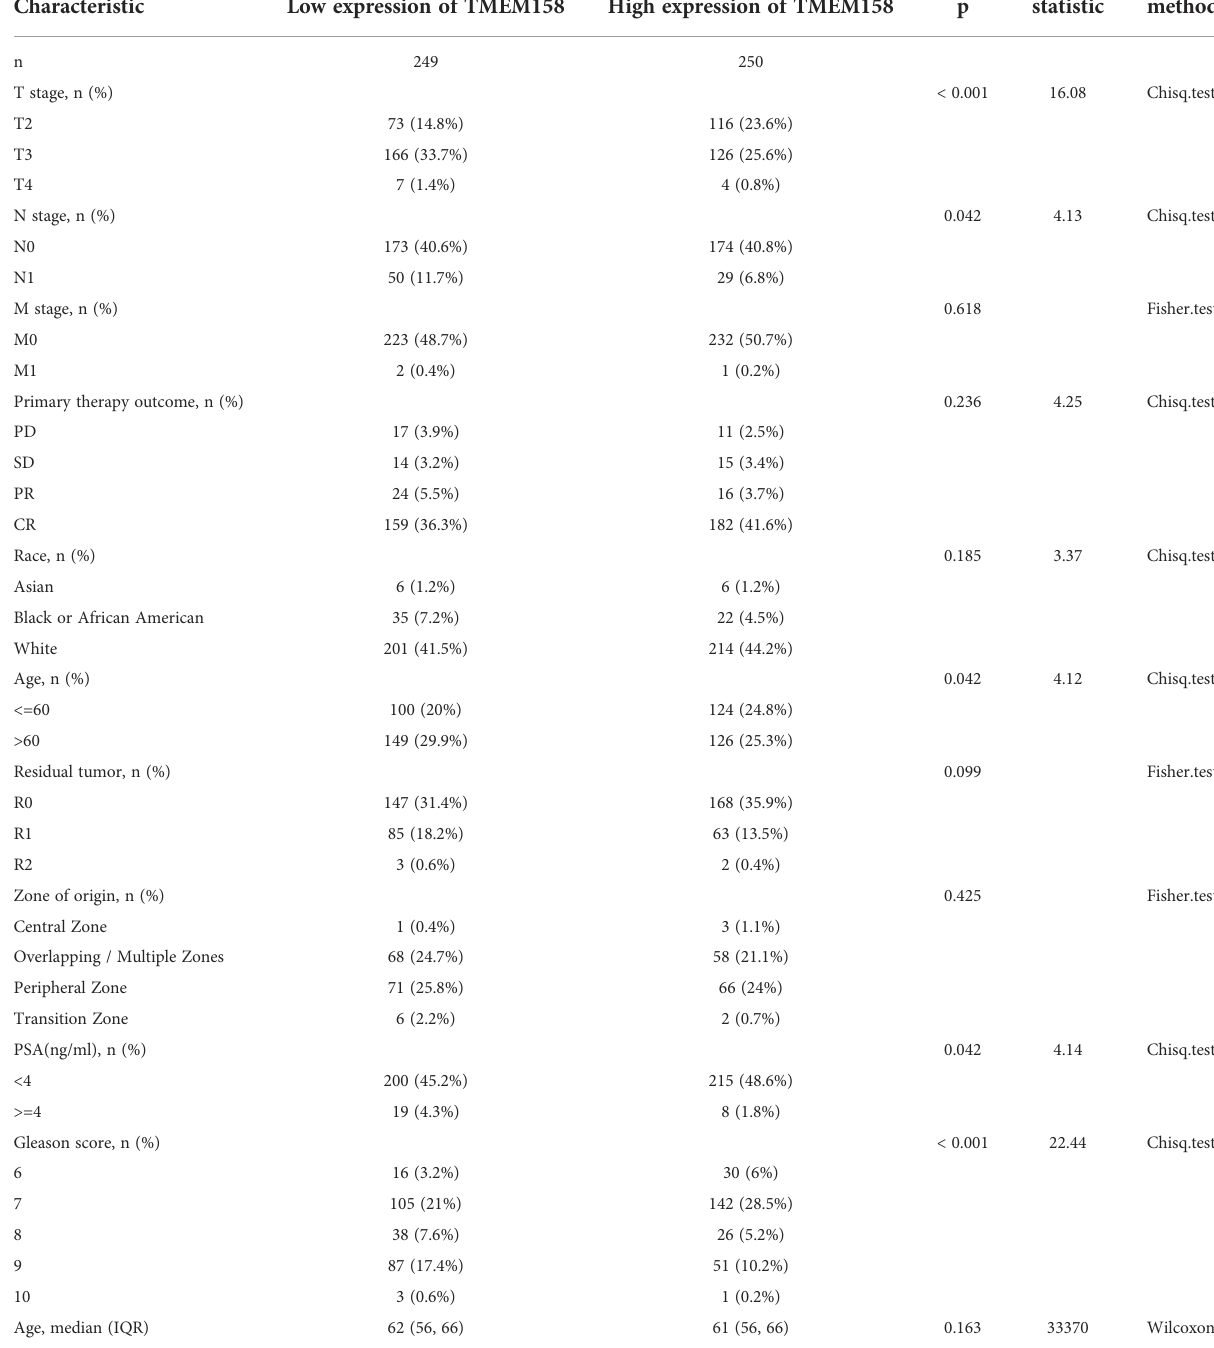
TABLE 1 TMEM158 expression and clinicopathological parameters in prostate cancer patients. Characteristic Low expression of TMEM158 High expression of